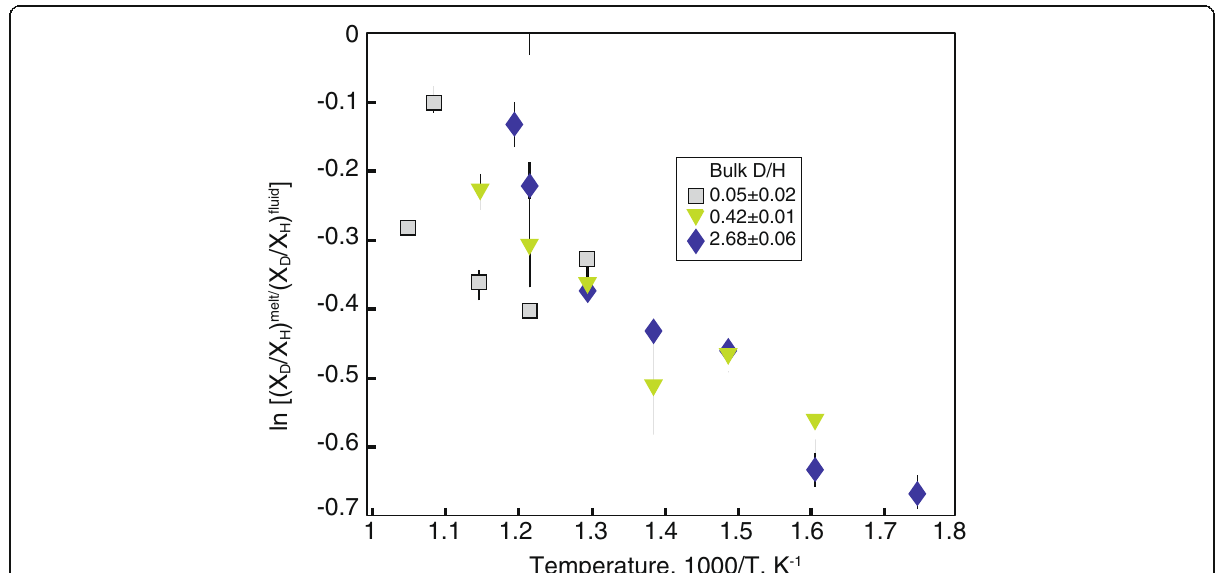
Fig. 5 D/H exchange equilibrium coefficient between coexisting fluid and melt in silicate – H 2 O as a function of temperature and bulk D/H abundance ratio (data from Dalou et al. 2015)